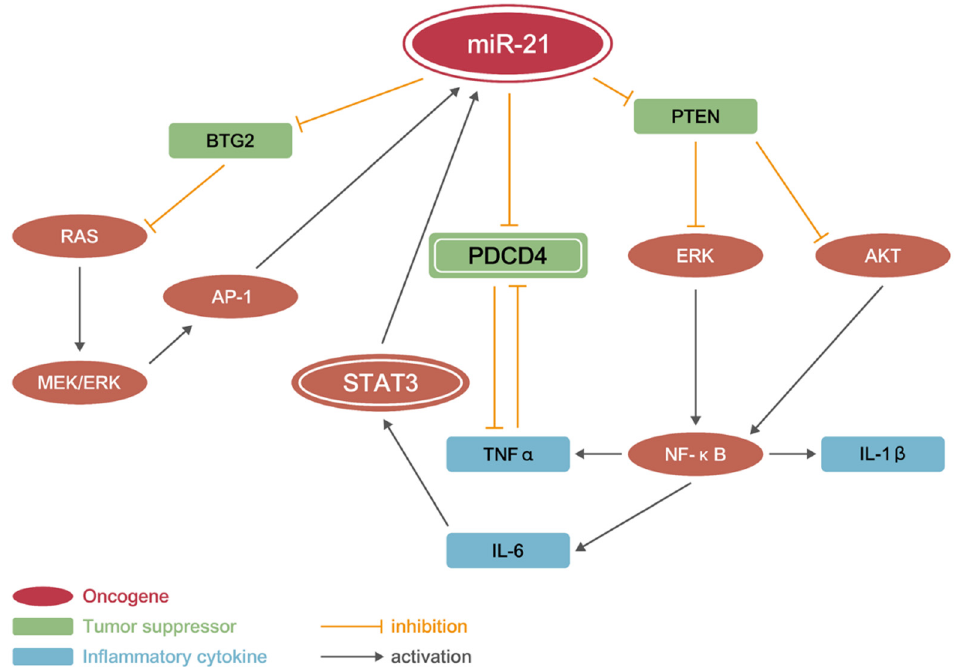
Figure 7. miR-21 Promotes CAC development by activating PI3K/AKT, STAT3, and PDCD4/TNF- α (PSP) signaling networks. Representative images of miR-21-mediated gene regulatory network in CAC/CRC development. miR-21 can induce CRC or colitis-associated cancer (CAC) in ImiR-21 through another PI3K/AKT, PDCD4/TNF- α , and IL-6/STAT3 signaling network, leading to initial inflammation. miR-21 and TNF- α repress PDCD4 and its tumor-suppressive activity; eventually, active STAT3 stimulates a strong inflammatory response and activates the invasion/metastasis process of tumor cells.